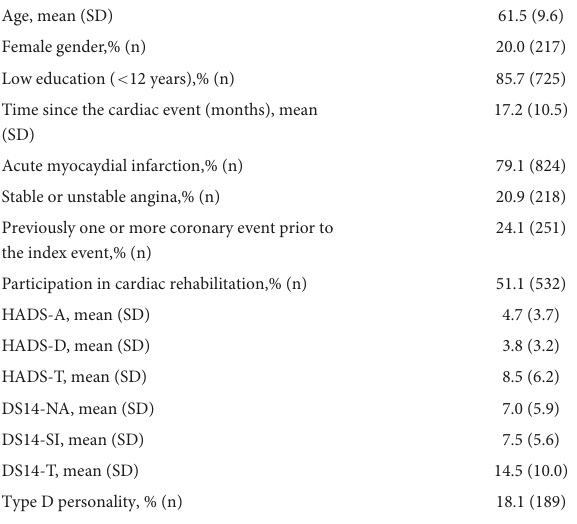
TABLE 1 Clinical characteristics of the patients.